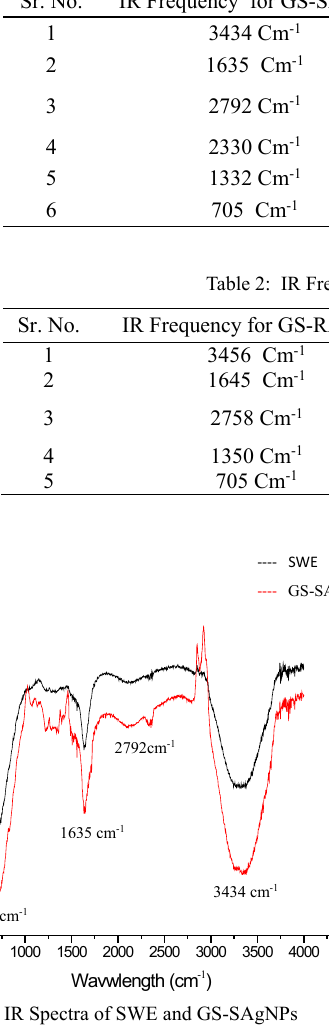
Fig. 4(a): IR Spectra of SWE and GS-SAgNPs Table No. 1 IR Frequency Band for GS-SAgNPs Table 1: IR Frequency Band for GS-SAgNPs Sr. No.